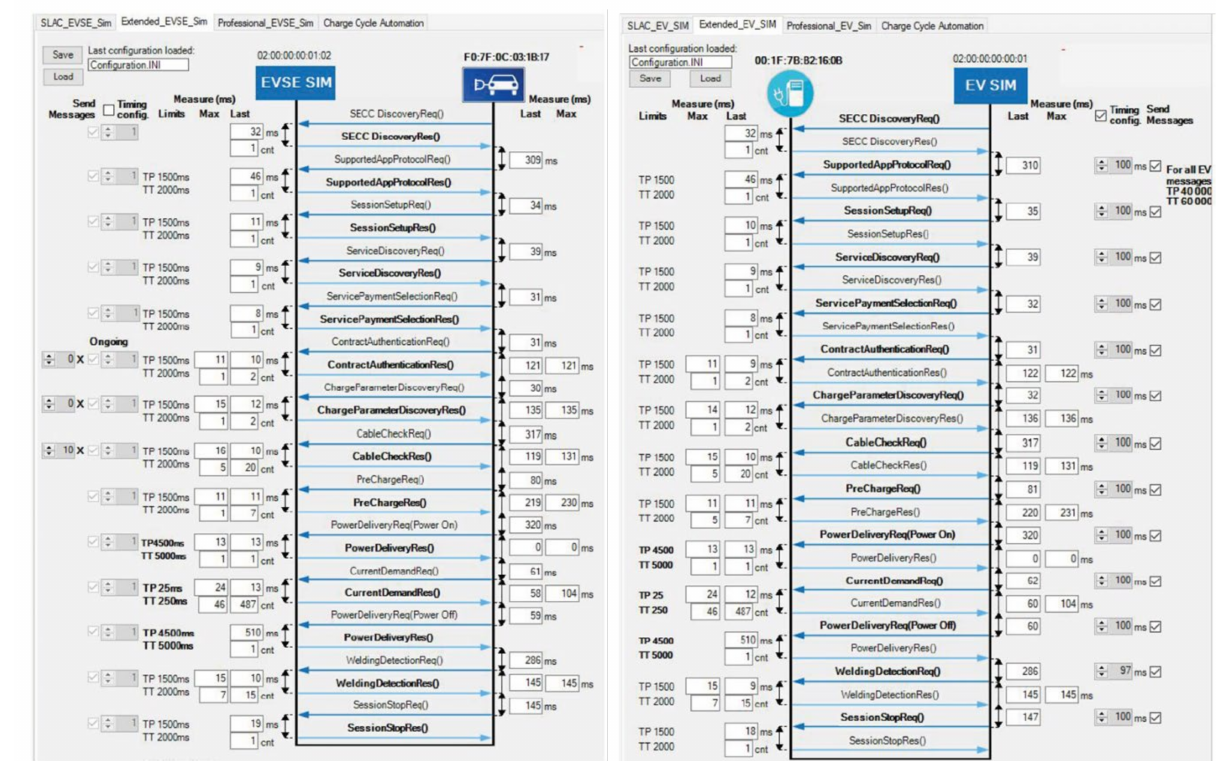
Figure 19. Panels of communication between real EV and